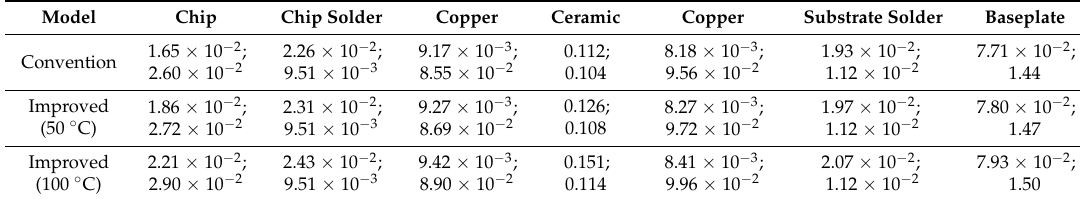
Table 3. The RC parameters of the two models in different condition ( R ; C , °C/W; J/°C).